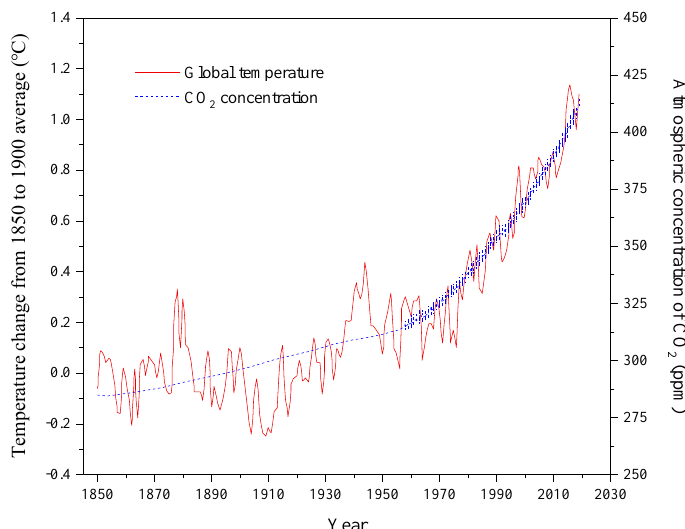
Figure 1. Correlation between atmospheric concentration of CO 2 and the global temperature since 1850s (Data from [1,2]).